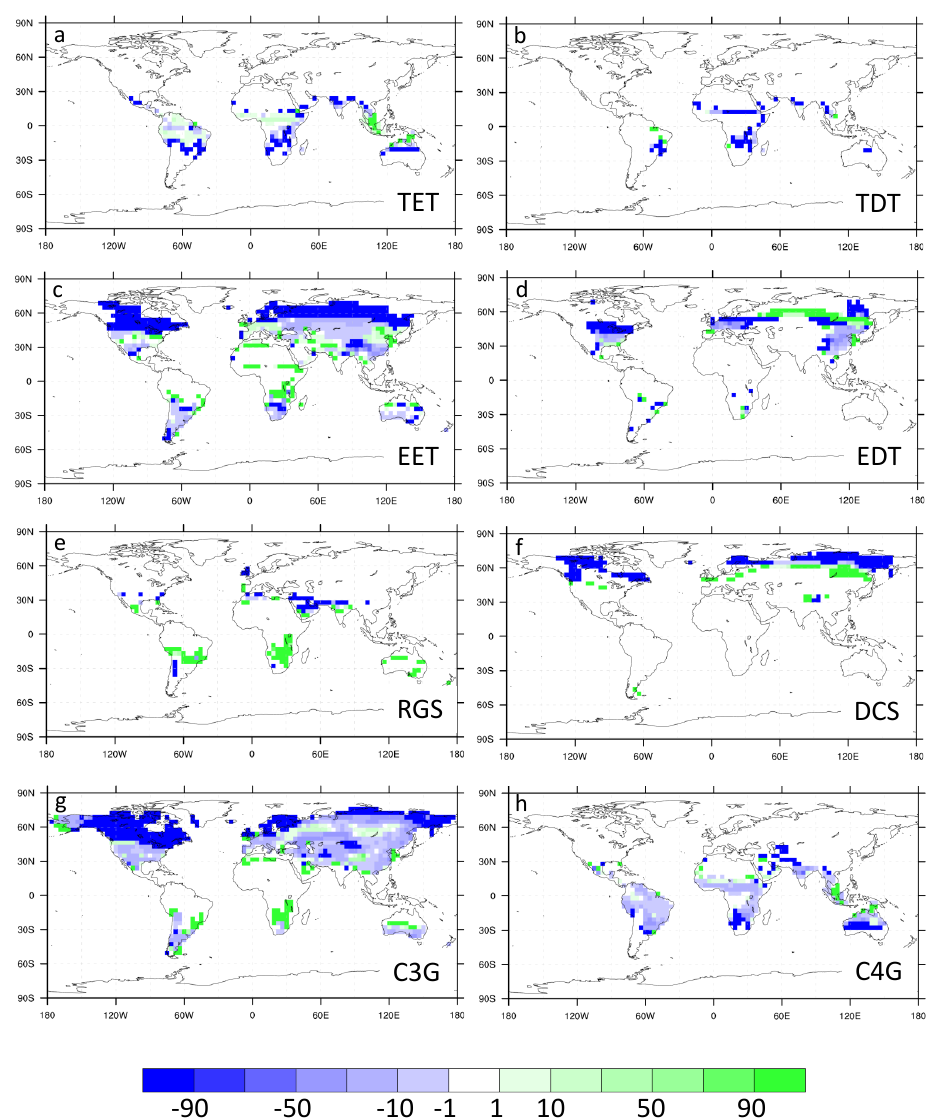
Fig. 5. Differences in fractional coverage (given in % coverage of each grid cell) between glacial and pre-industrial vegetation patterns (LGM–pre-industrial) for each PFT (for acronyms see Fig.